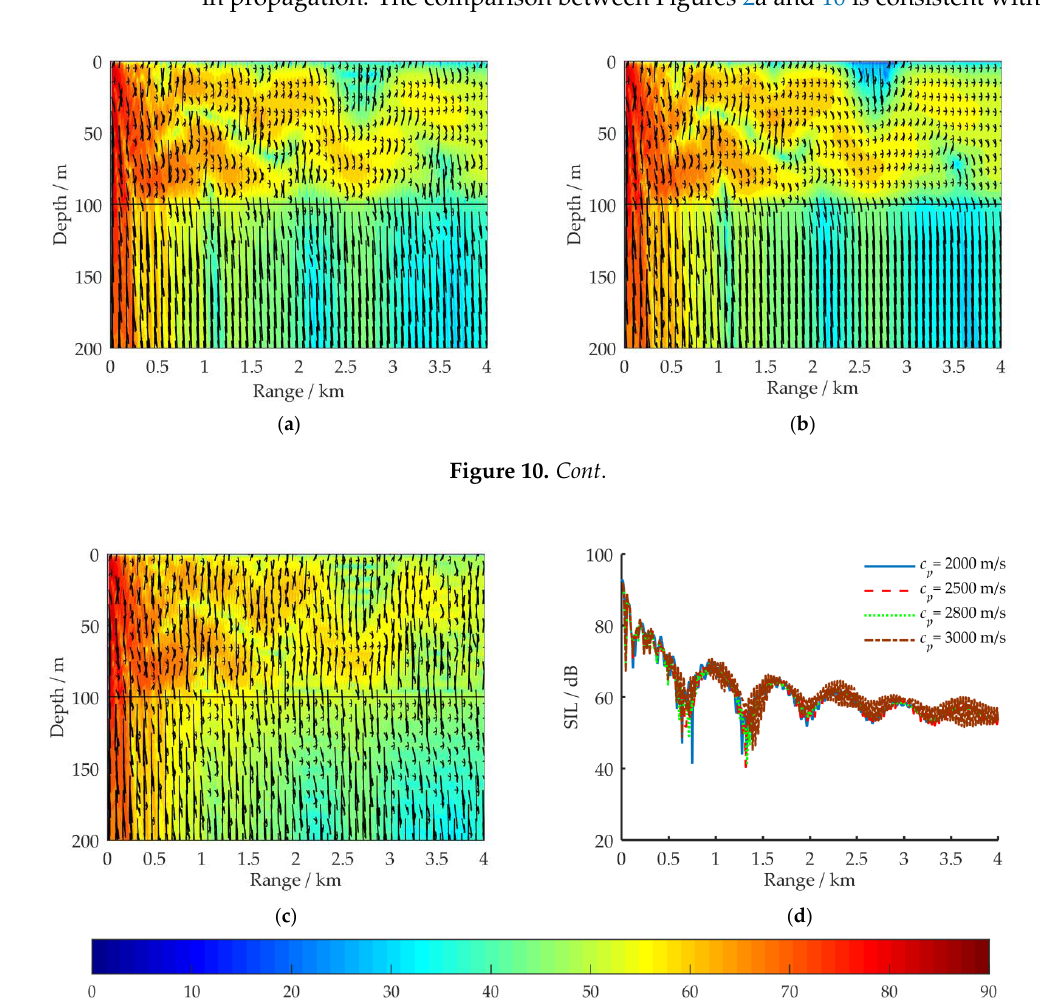
Figure 10. Distribution of the 100 Hz acoustic energy flux (SIL) in a full waveguide of shallow water for different P-wave speed in sea bottom. ( a ) c p = 2500 m/s; ( b ) c p = 2800 m/s; ( c ) c p = 3000 m/s; ( d ) comparison results of SIL curves for four types of simulation conditions: c p = 2000, 2500, 2800, and 3000 m/s, with a receiving depth of z = 50 m.